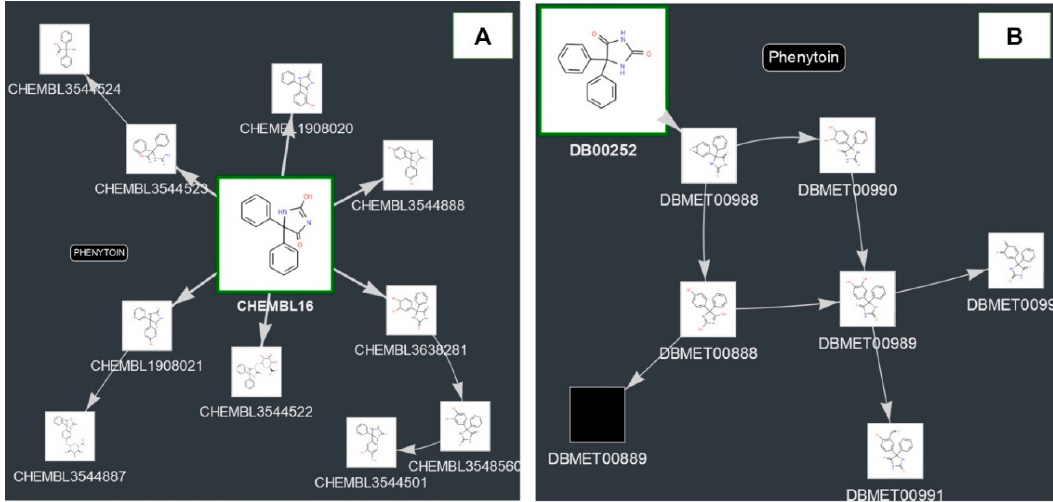
Figure 1. Metabolism graphs for Phenytoin: ( A ) ChEMBL (http: // www.way2drug.com / metapass / view_path_new.php?id = 93). ( B ) DrugBank (http: // www.way2drug.com / metapass / view_path_new.php?id =